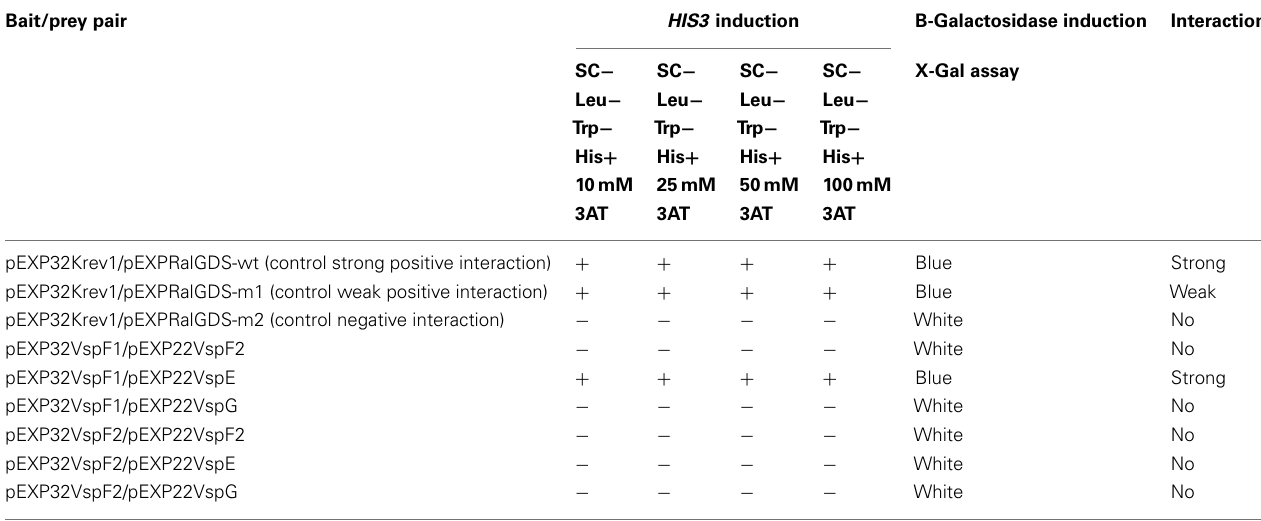
TableA2 | Results of yeast two-hybrid screening to detect protein:protein interactions between putative needle proteins and putative chaperones.